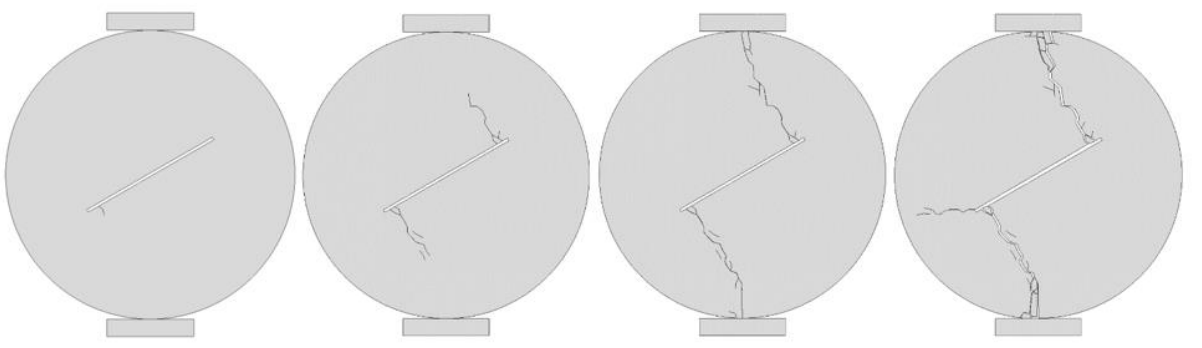
Figure 7. Fracture process for Brazilian disc with a crack of 60° angle.